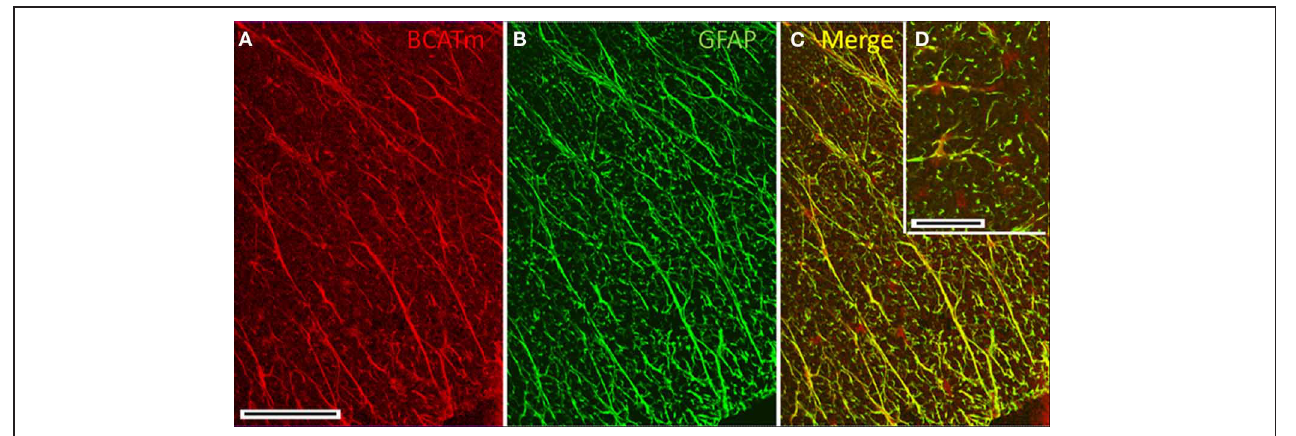
FIGURE 4 | Immunolocalization of BCATm in the spinal cord. (A) Anti-BCATm strongly labels elongate, radially oriented elements in the white matter of the spinal cord. (B) Labeling for GFAP in the same section as shown in panel A shows that the radial elements are glial